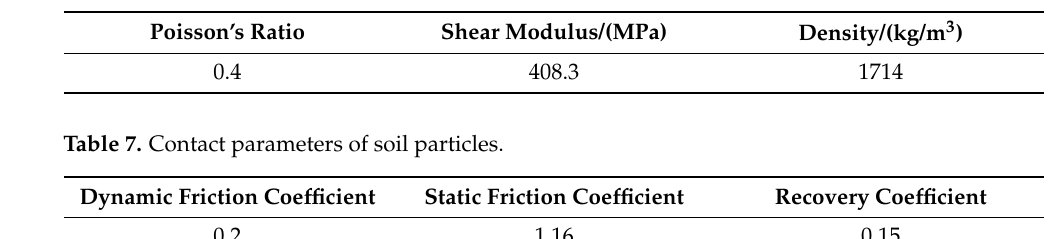
Table 6. Intrinsic parameters of soil.